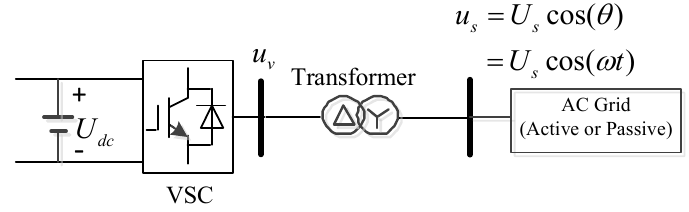
Figure 2. Typical structure of a non-synchronous generator source.